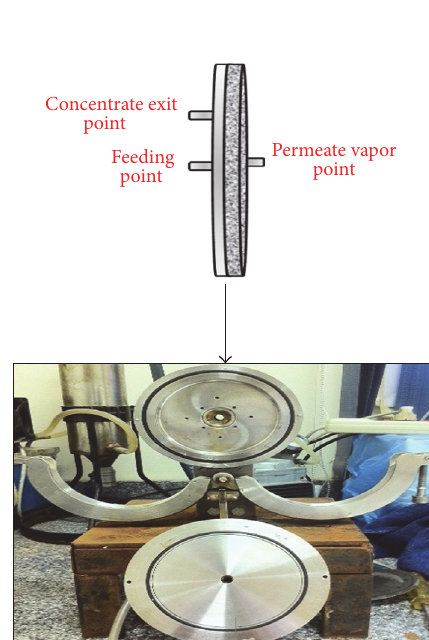
Figure 3: O-ring membrane